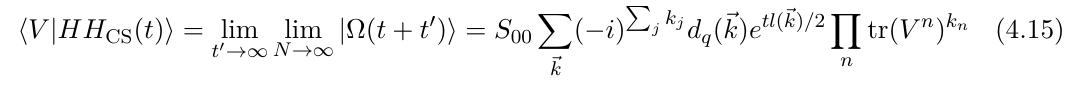
Figure 17 . The geometric transition, combined with the t 0 → ∞ limit maps the state on the deformed conifold (left figure) to the Hartle-Hawking state on the resolved conifold. state on the resolved conifold. We can therefore identify the Chern-Simons